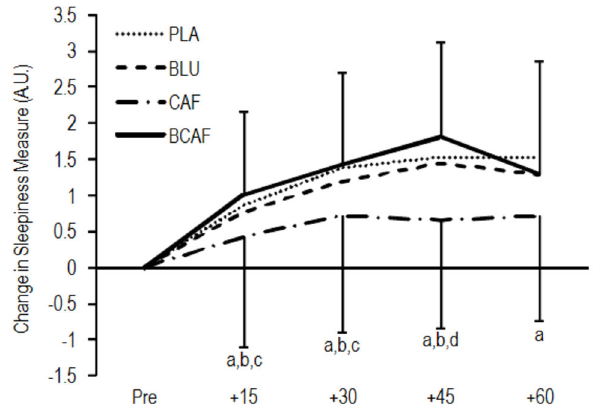
Figure 4. Change in performance of the Eriksen flanker psychomotor task. a: small difference from PLA, b: small difference from CAF, c: moderate difference from CAF. PLA: white light/placebo; CAF: white light/240 mg caffeine; BLU: blue light/placebo; BCAF: blue light/240 mg caffeine, CON: Congruent flanker presentations, INCON: Incongruent flanker presentations.